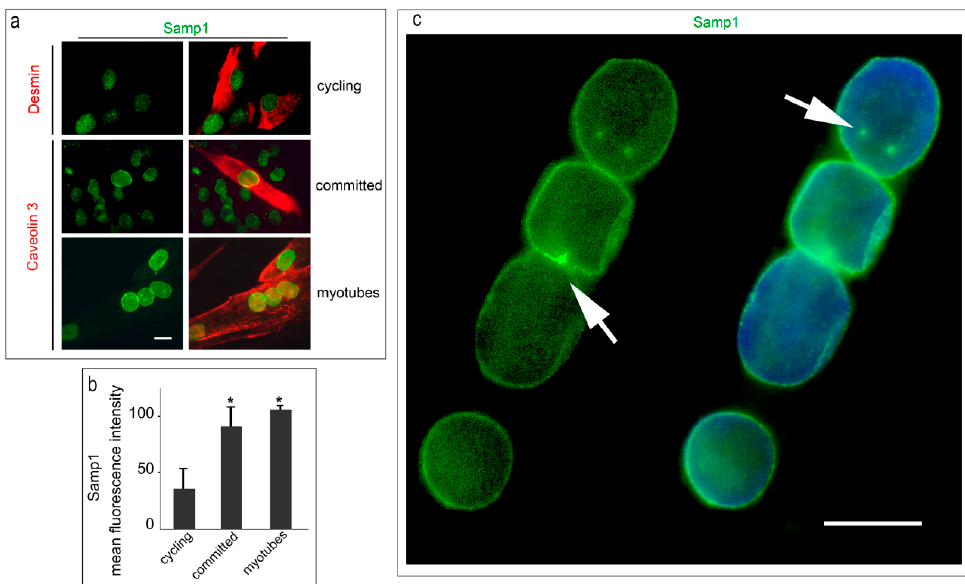
Figure 1. Samp1 is recruited to the nuclear periphery in differentiating human control myoblasts. ( a ) Samp1 (green) and desmin (red) were co-stained in cycling human myoblasts (cycling). Samp1 and caveolin 3 (red) were co-stained in committed myoblasts (committed) and myotubes (myotubes). Nuclear envelope localization of Samp1 is observed in all caveolin 3-positive cells. ( b ) Quantitative analysis of mean fluorescence intensity is reported in the graphs. ( c ) A myotube labeled with Samp1 antibody and counterstained with DAPI shows a few sites of accumulation of Samp1 in areas possibly corresponding to centrosome remnants (arrows). Statistically significant differences by the Mann Whitney test are indicated by asterisks (*). Scale bars, 10 µm.